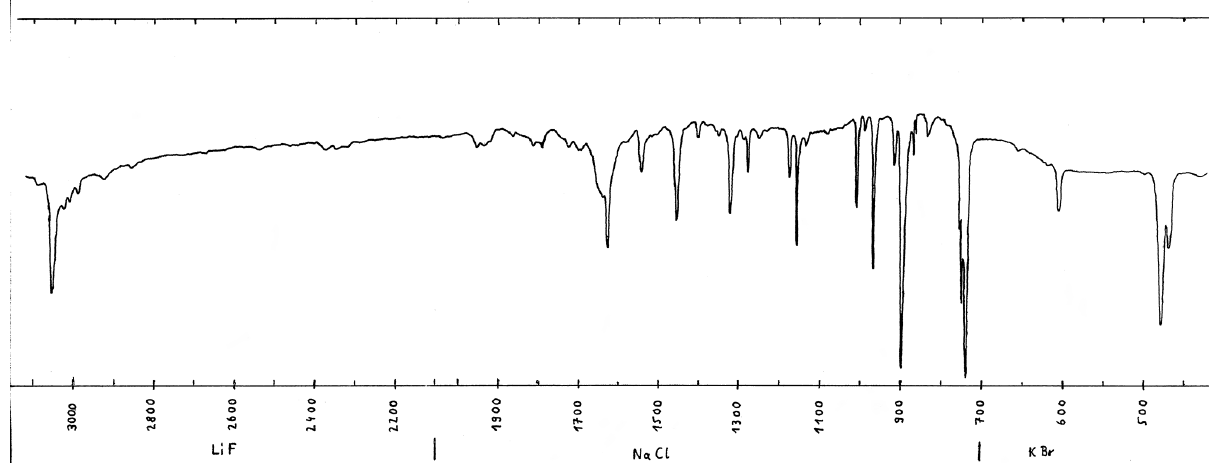
Figure 3. Infrared spectrum (transmission) of freitalite from Freital, Germany, from Witzke